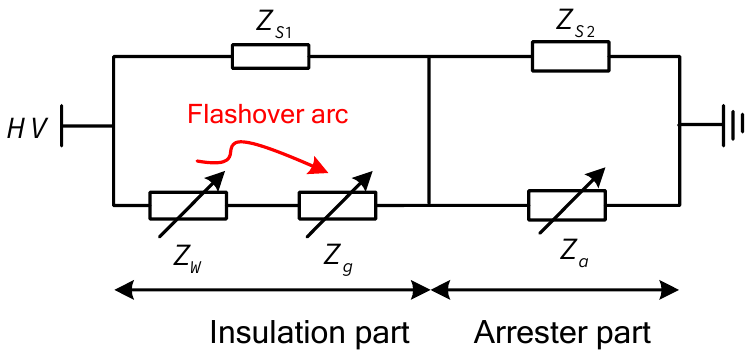
Figure 7. Equivalent circuit model of the test specimens under rain condition.